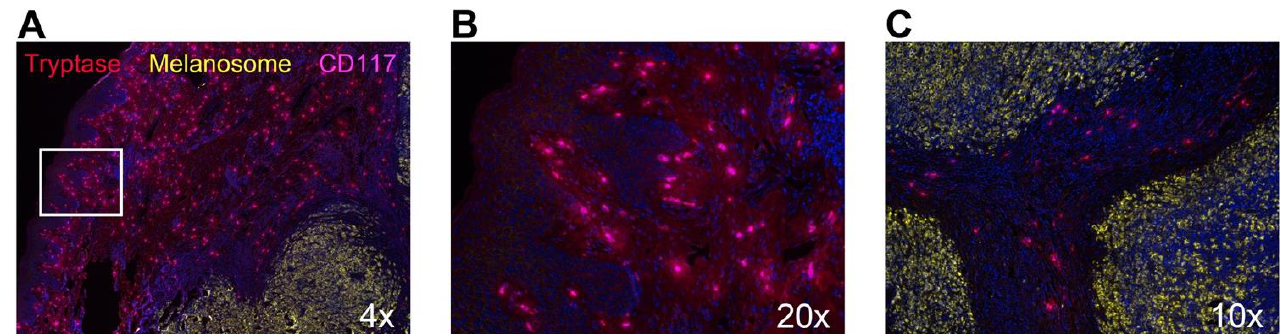
Figure 2. Mast cells resident in the epithelium and stroma of a patient with biotherapy-resistant cutaneous melanoma. ( A – C ) Fixed and paraffin-embedded melanoma sections were labeled against tryptase (red), CD117 (c-Kit; pink), melanosome (yellow), and DAPI (blue) using Opal reagents (Akoya Bioscience). Slides were scanned using the Akoya Biosciences Mantra 2 TM Quantitative Pathology Workstation at either 4× ( A ), 20× ( B ), or 10× ( C ) magnification. ( A ) Representative image illustrating the abundance of tryptase- and CD117-expressing mast cells surrounding melanosome-expressing biotherapy-resistant melanoma. ( B ) Zoom of mast cells in the boxed region in ( A , C ), Mast cells predominately populate the stroma of biotherapy-resistant melanoma.